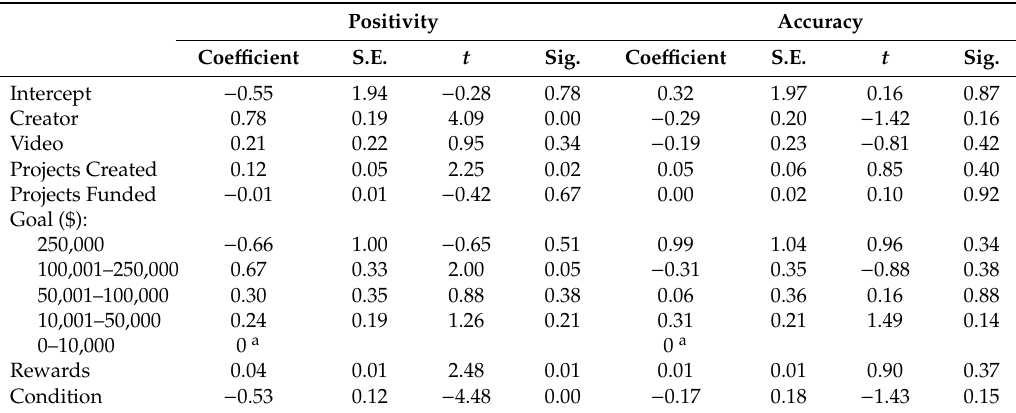
Table 4. Generalized linear mixed model (study 2, N =